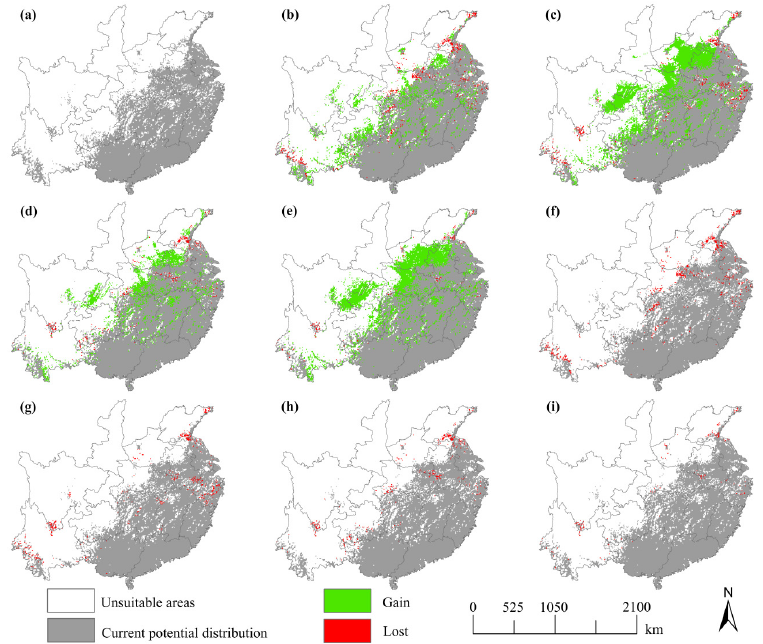
Figure 3. Projected changes of the distribution range of Sapindus mukorossi in China under different modeling set-ups: ( a ) current potential distribution; ( b ) full dispersal × average GCMs × RCP2.6; ( c ) full dispersal × average GCMs × RCP8.5; ( d ) full dispersal × consensus GCMs × RCP2.6; ( e ) full dispersal × consensus GCMs × RCP8.5; ( f ) no dispersal × average GCMs × RCP2.6; ( g ) no dispersal × average GCMs × RCP8.5; ( h ) no dispersal × consensus GCMs × RCP2.6; and ( i ) no dispersal × consensus GCMs × RCP8.5.